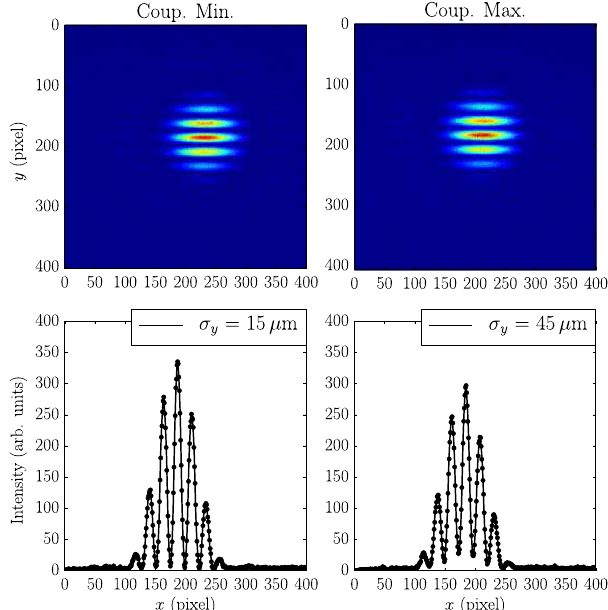
FIG. 4. Interferograms at minimum and maximum coupling used to measure the vertical beam size, and the data analysis to obtain the results. Black dots represent the projection of the central slice of the interferogram, while the black line is obtained fitting the data using Eq. (1). Note the different visibilities leading to different beam